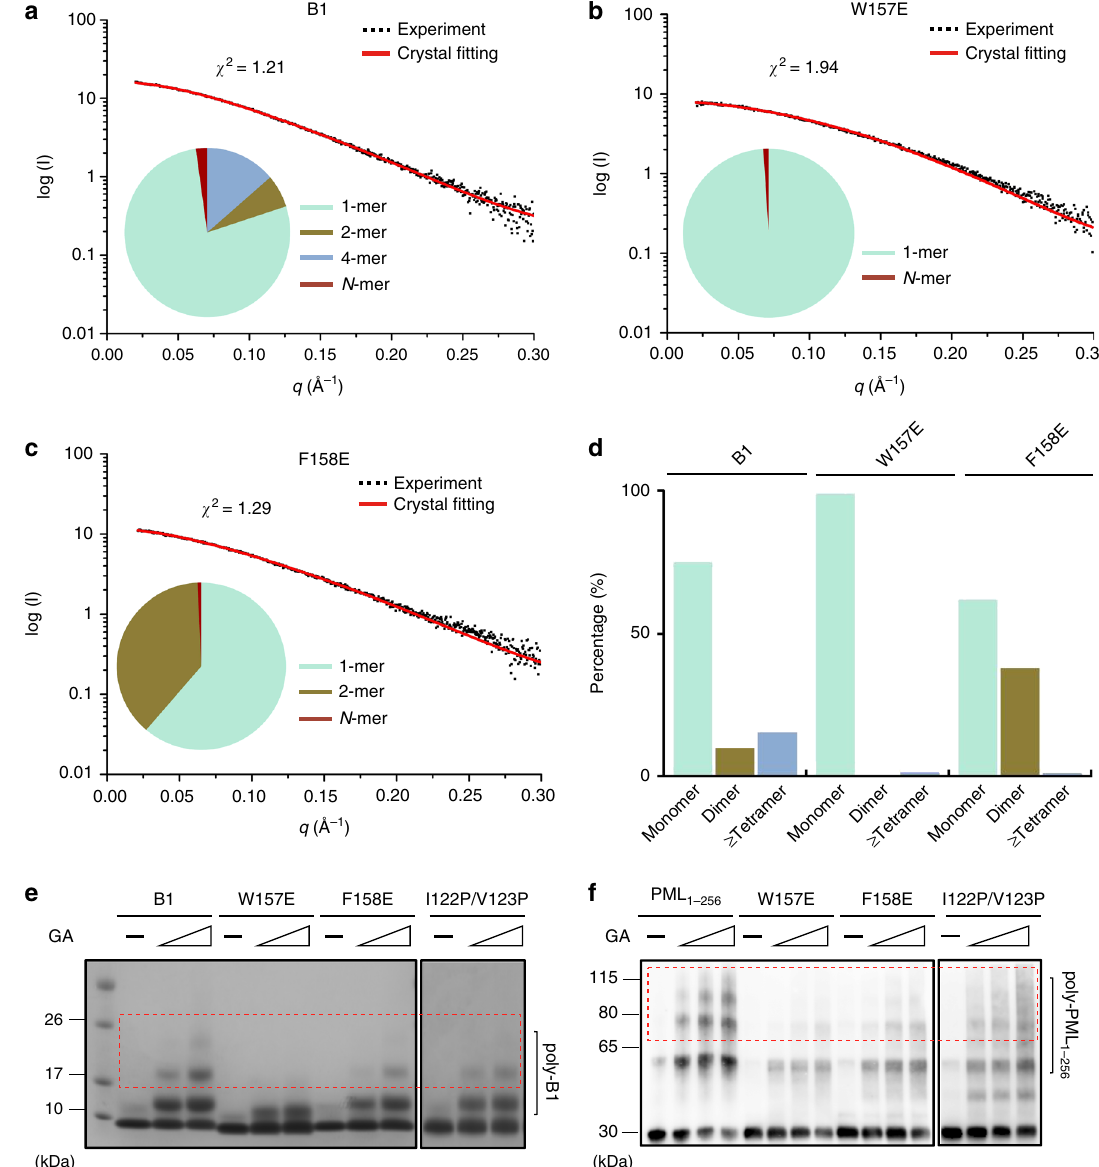
Fig. 4 SAXS and cross-linking assays of PML B1-box oligomerization. a – c SAXS analysis of WT B1 ( a ), B1 W157E ( b ), and B1 F158E ( c ). The experimental data are shown in black dots. The theoretical scattering pattern derived from PML B1 multimers is shown in red line. Bottom-left panels of each fi gure, the oligomeric distribution/dynamic in solution. Source data are provided as a Source Data fi le. d Statistical summary of SAXS experiments. e , f Oligomerization-dependent crosslinking assays. In e , PML B1 and mutants were cross-linked by an increased concentration of glutaraldehyde (GA). In f , PML 1 – 256 and mutants were cross-linked by an increased concentration of glutaraldehyde (GA). The poly-B1 and poly-PML 1 – 256 are highlighted with brackets and red boxes. Source data are provided as a Source Data fi